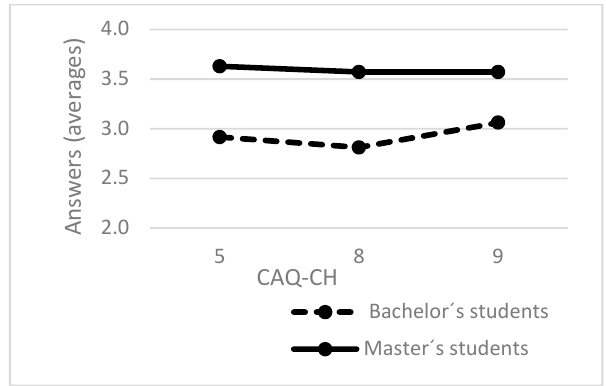
Figure 5. Answers of undergraduate and graduate students in CAQ-CH.